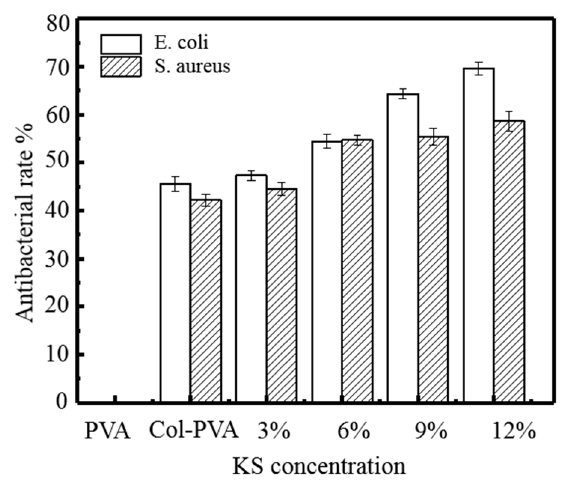
Figure 6. Antibacterial rate of E. coli and S. aureus at different KS content of KS-Col-PVA composite film. 2.7. E ff ect of Ultrasonic Treatment Film Forming Solution on the Performance of the Composite Film